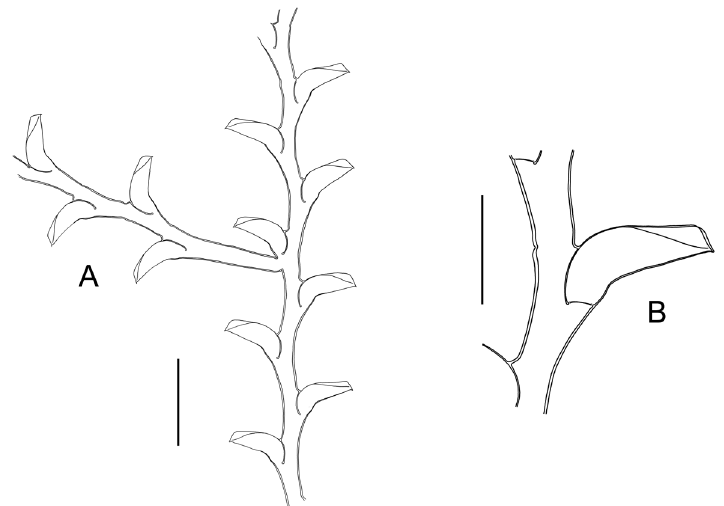
Fig. 9. Diphasia alternata Galea, sp. nov. A–B . Portion of stem with proximal part of side branch (A), hydrotheca (B), both from sample MNHN-IK-2015-471. Scale bars: A = 1 mm; B = 500